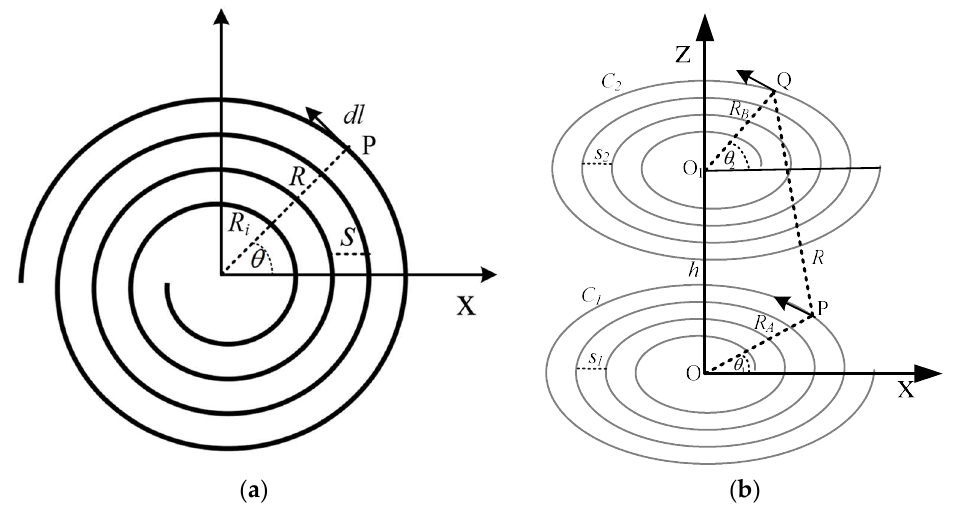
Figure 1. ( a ) Planar spiral coil. ( b ) Aligned circular spiral coil.